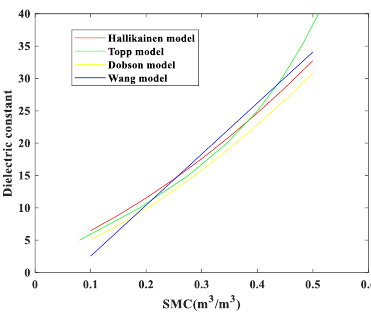
Figure 4 . The four soil models on American clay soil （ C=0.7 ， S=0.23 ） .